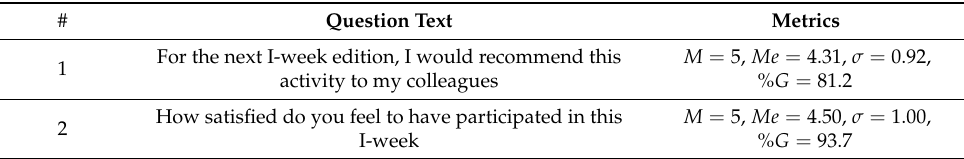
Table 6. Mode ( M ), mean ( Me ), standard deviation ( σ ), and percentage of “good” opinions ≥ 8.0 (% G ) for the first overall performance questions (11 and 12) in the